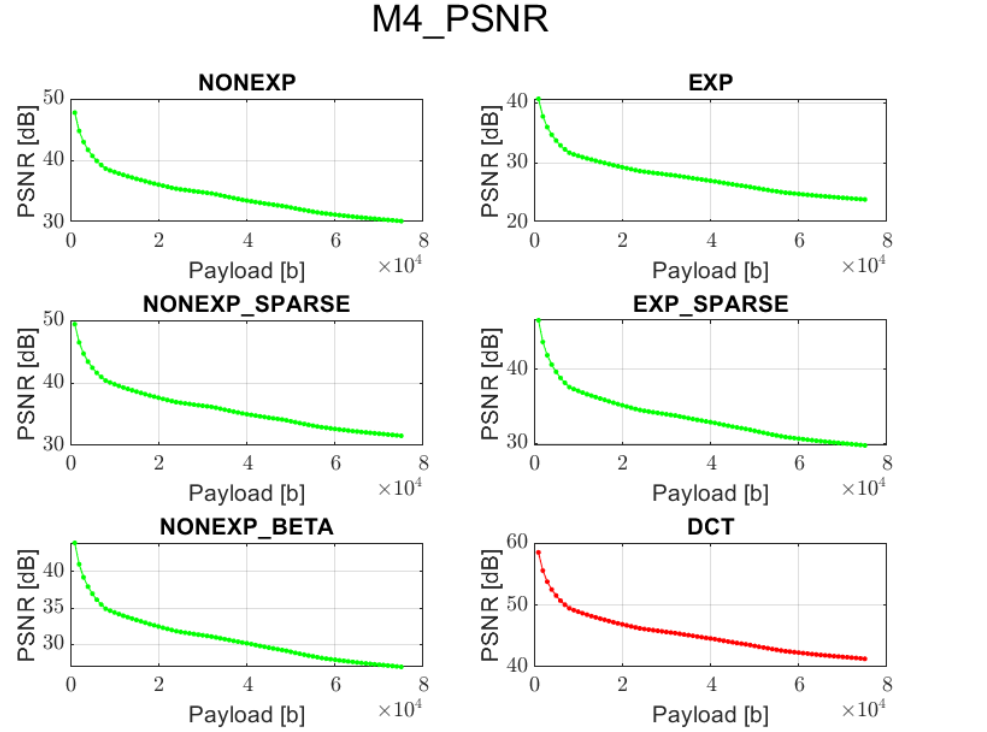
Figure 5. Relation between PSNR and embedded data size for method 4 and all transform